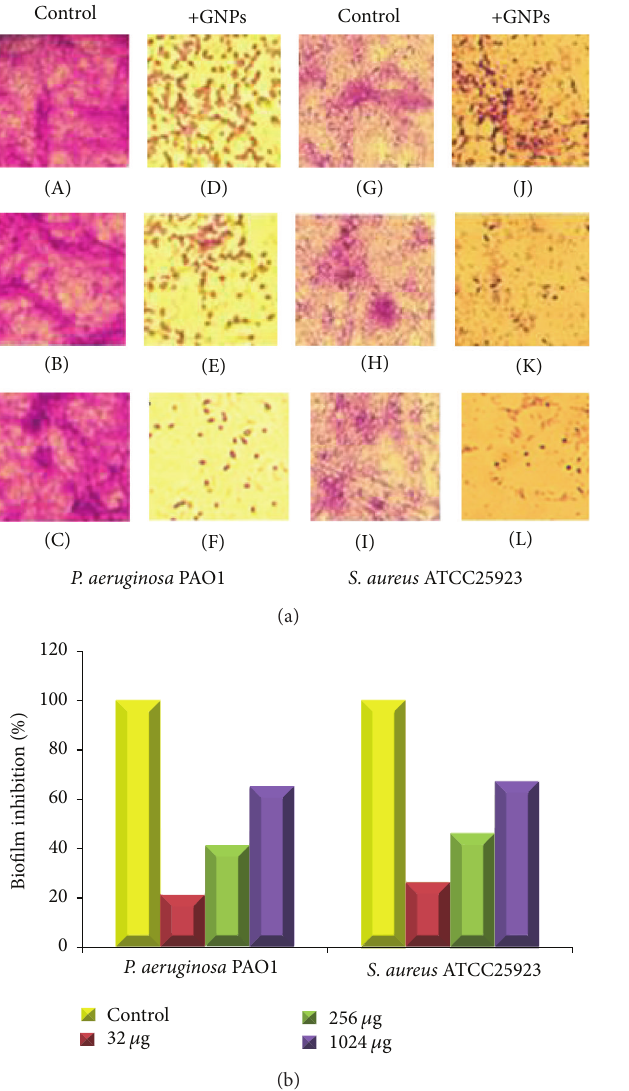
Figure 5: Micrographs of biofilm formation (a) and biofilm inhibi- tion by different concentrations of GNPs (b).